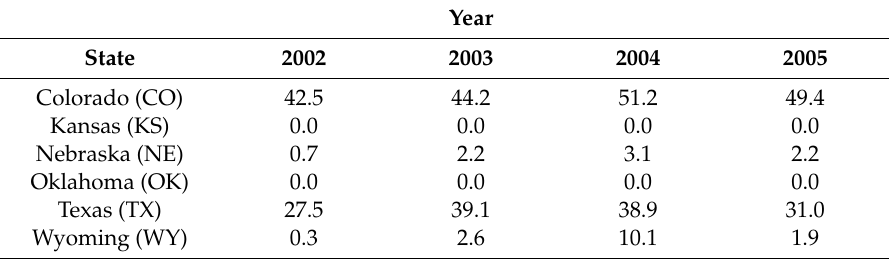
Table 2. Adoption rate (percent of total area) of resistant varieties to aphid by